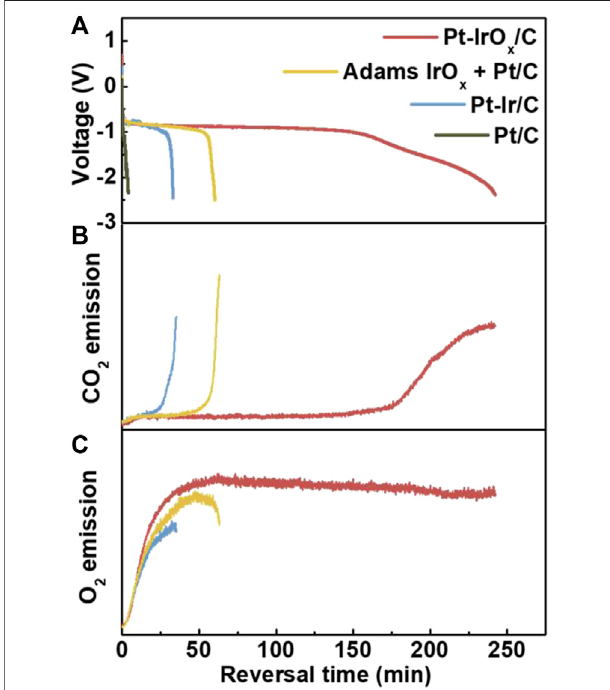
FIGURE 4 | Reversal tolerance ability of various RTAs. Release of (B) CO 2 (m/z44)and (C) O 2 (m/z32)duringthevoltagereversaltest.Reproduced with permission (Roh et al., 2019). Copyright 2019,